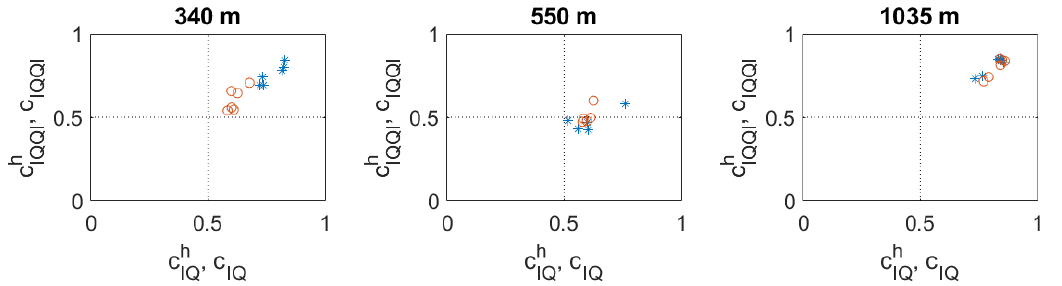
Figure 4. Results of inland water experiment; correlation coefficients calculated on the basis of: time-varying impulse response (*) and pseudo-random binary sequence probe signal